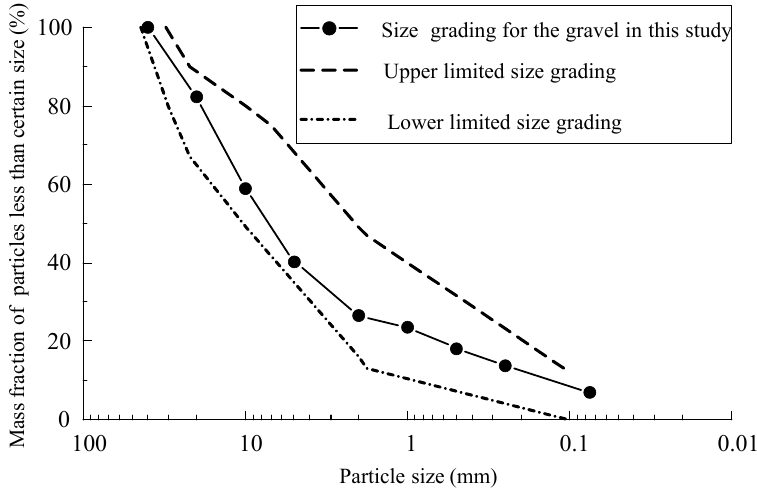
Figure 3. Particle size distribution of model filling. 176